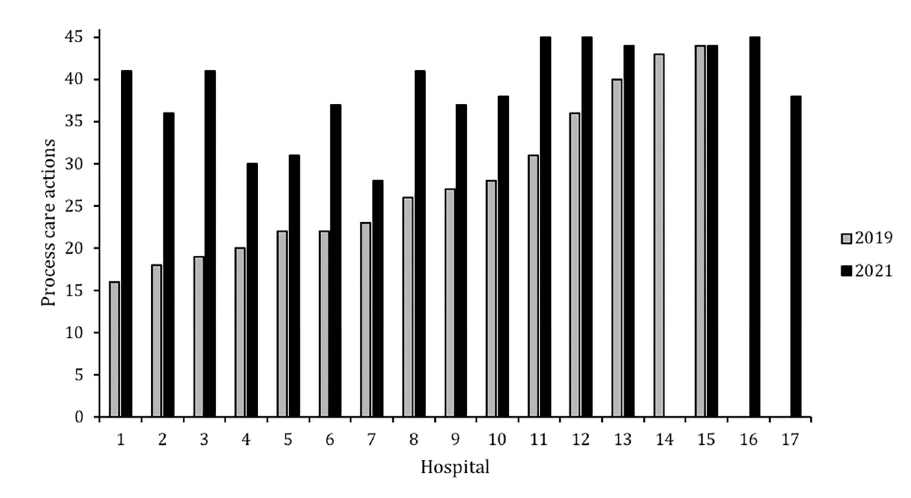
Fig 1. Variation in number of severe pediatric traumatic brain injury process care actions across 17 South American hospitals at two timepoints: 2019 and